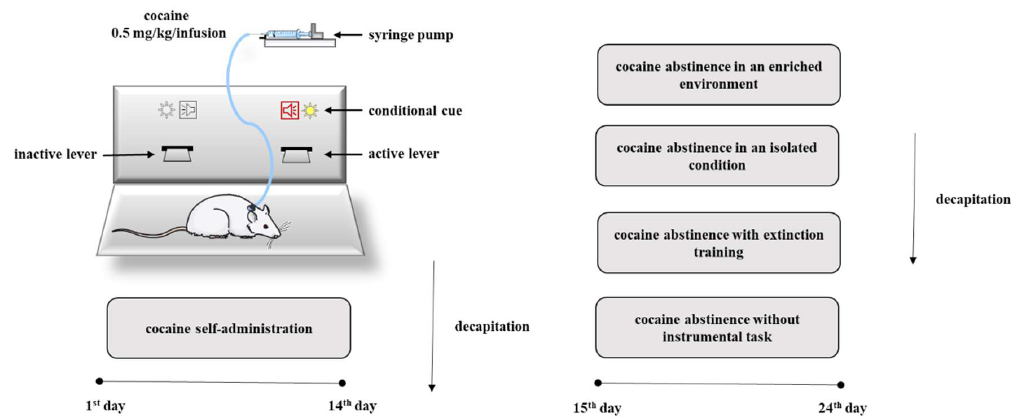
Figure 1. Diagram illustrating the experimental procedure.